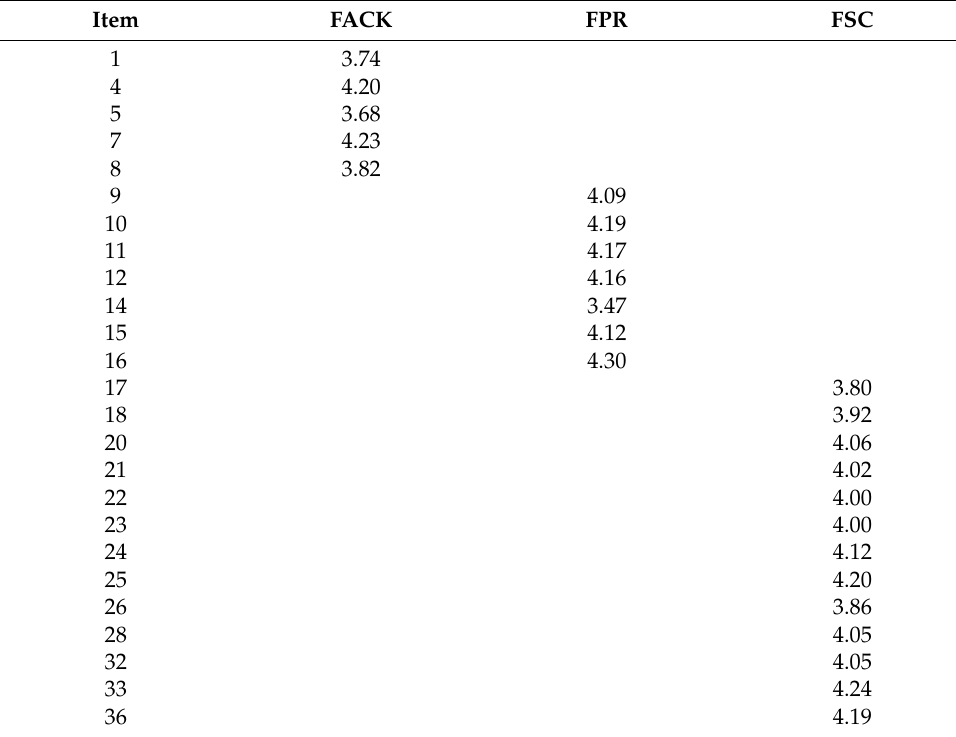
Table 2. Bayesian Exploratory Factor Analysis posterior